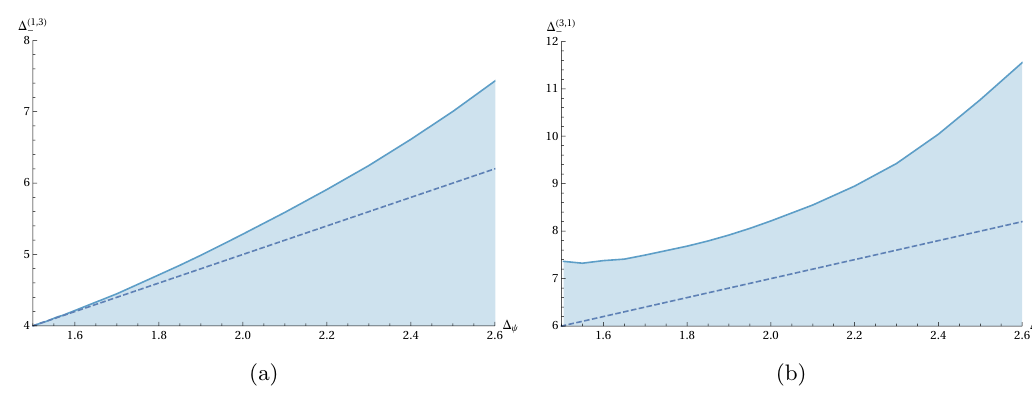
Figure 11 . Left: upper bound on the (cid:12)rst charged (1 ; 3) NTS operator. Right: upper bound on the (cid:12)rst (3 ; 1) NTS operator. The shaded region is the allowed one. The bounds have been computed at (cid:3) = 16. The dashed lines represent the GFT.